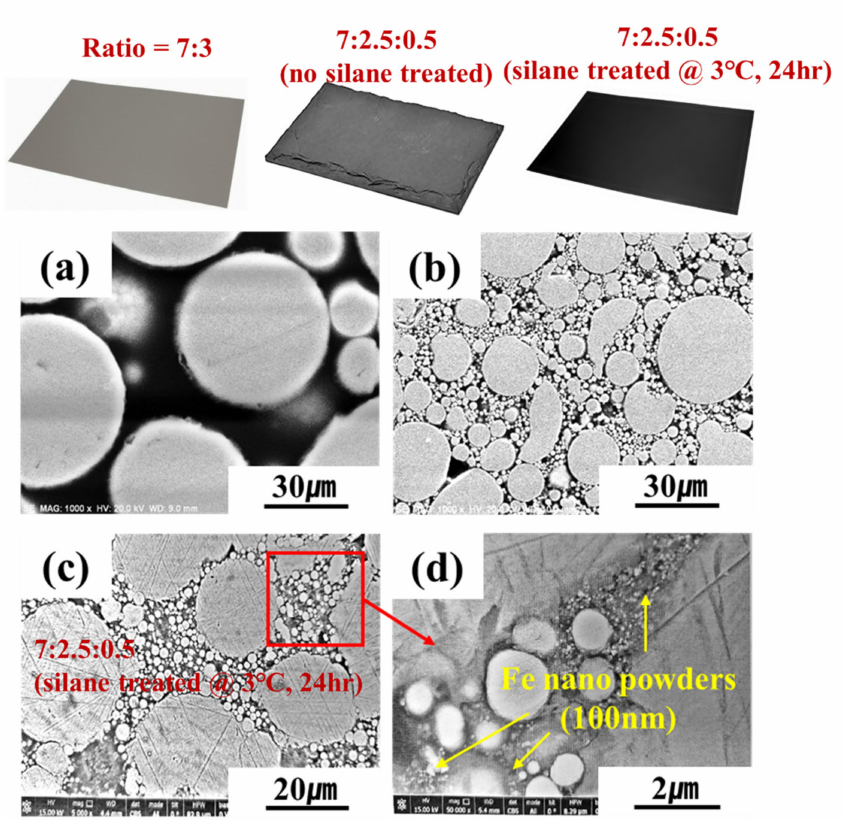
Figure 9. SEM image analysis results of magnetic sheet and sheet fracture surfaces according to mixing and surface-treatment conditions: ( a ) ratio 7:3, ( b ) 7:2.5:0.5 by using silane treatment, and ( c , d ) 7:2.5:0.5 by using silane treatment at 3 ◦ C for 24 h. Table 2. Evaluation results of the surface characteristics of the magnetic sheet fabricated under each